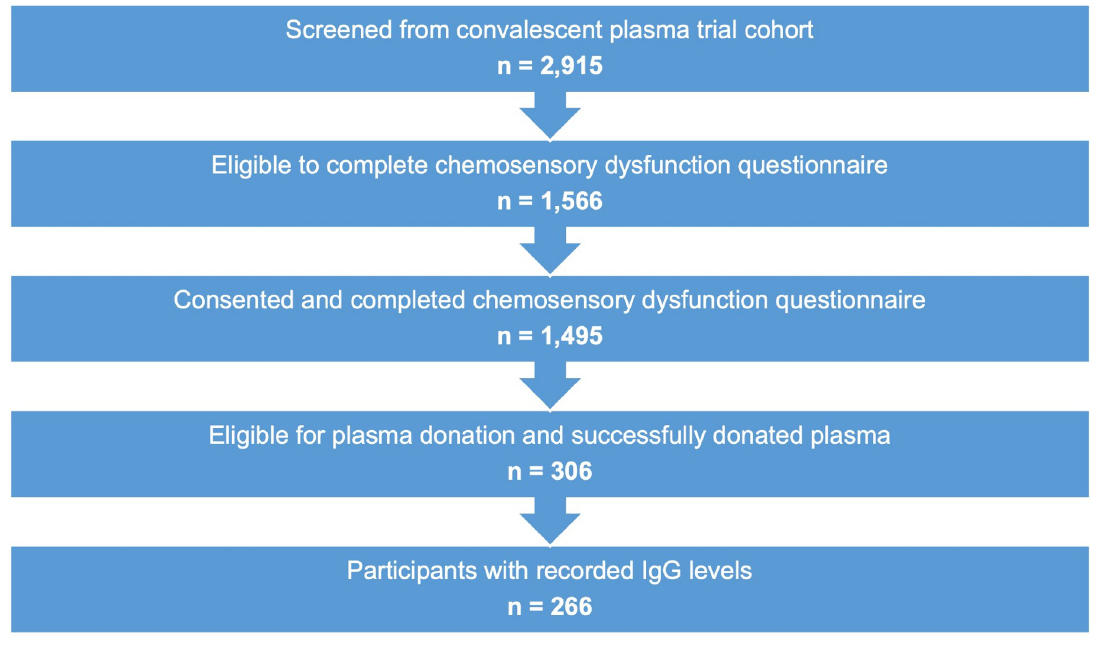
Fig 1. Flow diagram illustrating participant